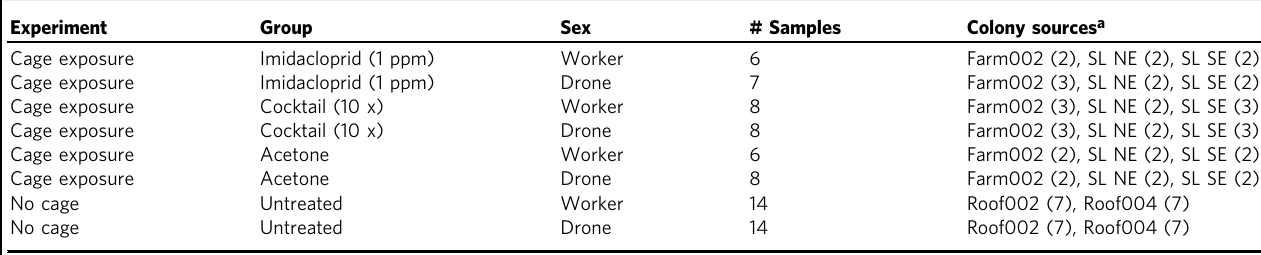
Table 3 Sample sizes for proteomics